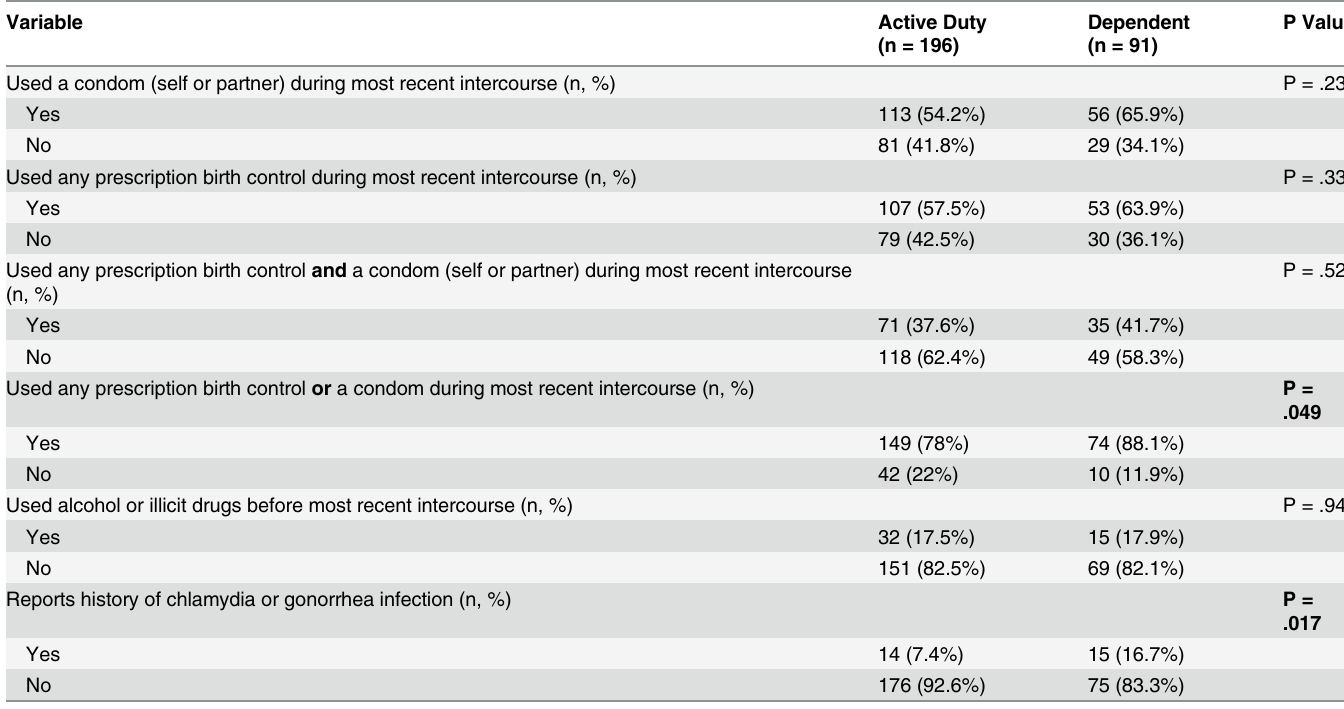
Table 4. Risk behaviors among patients aged 17 – 23 who indicated history of sexual intercourse in military adolescent clinics (n =